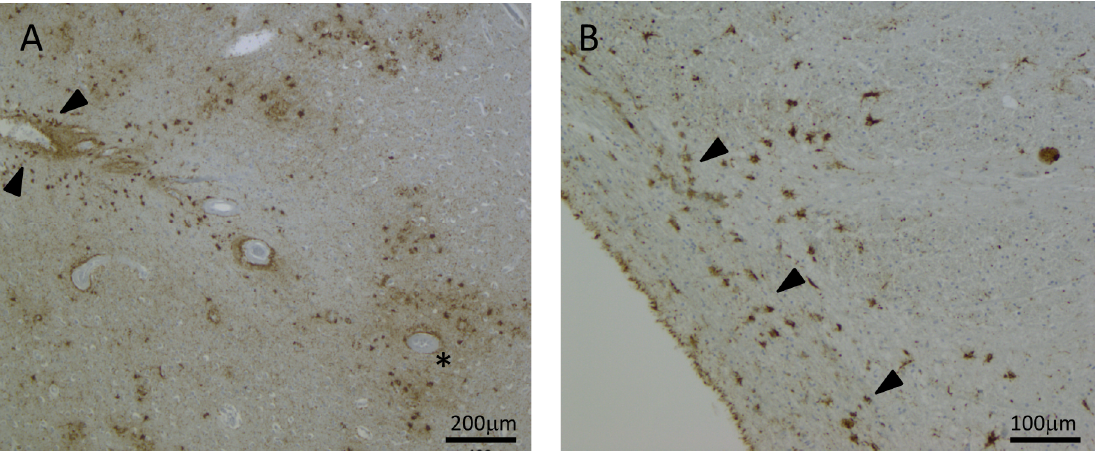
Figure 2. Thorn-shaped astrocytes in subpial (arrowheads) and perivascular sulcal depth (asterisk) arrangements in chronic traumatic encephalopathy (CTE), 50× magnification ( A ); subpial thorn-shaped astrocytes (arrowheads) adjacent to the substantia nigra region of the midbrain, 100× magnification ( B ). Immunostaining with AT8-tau antibody.